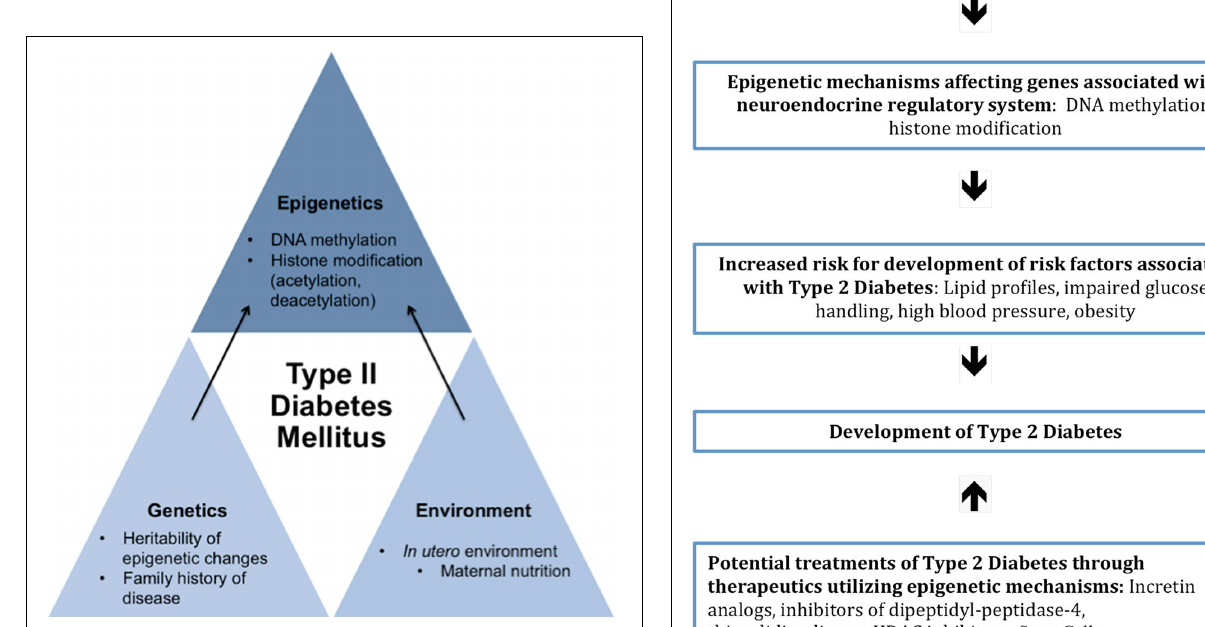
FIGURE 1 | Schematic proposing how genetics, environment, and epigenetics play a role in contributing to the development of type II diabetes mellitus. While genetics and environment have an impact on the development of T2DM on their own, new research indicates that in utero environment may cause specific epigenetic changes to the fetus’s genome that may cause susceptibility of the development of T2DM of the fetus later in life. Therefore, epigenetics also has an impact on the development of T2DM.